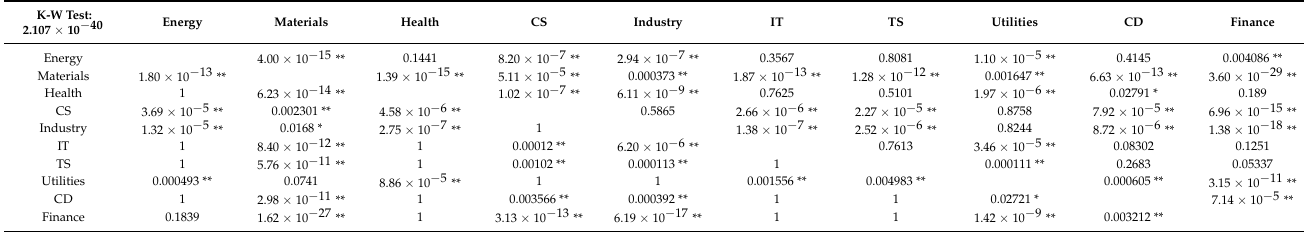
Table 7. Statistical significance of differences between sectors, Bonferroni corrected/incorrected. K-WTest: 2.107 × 10 − 40